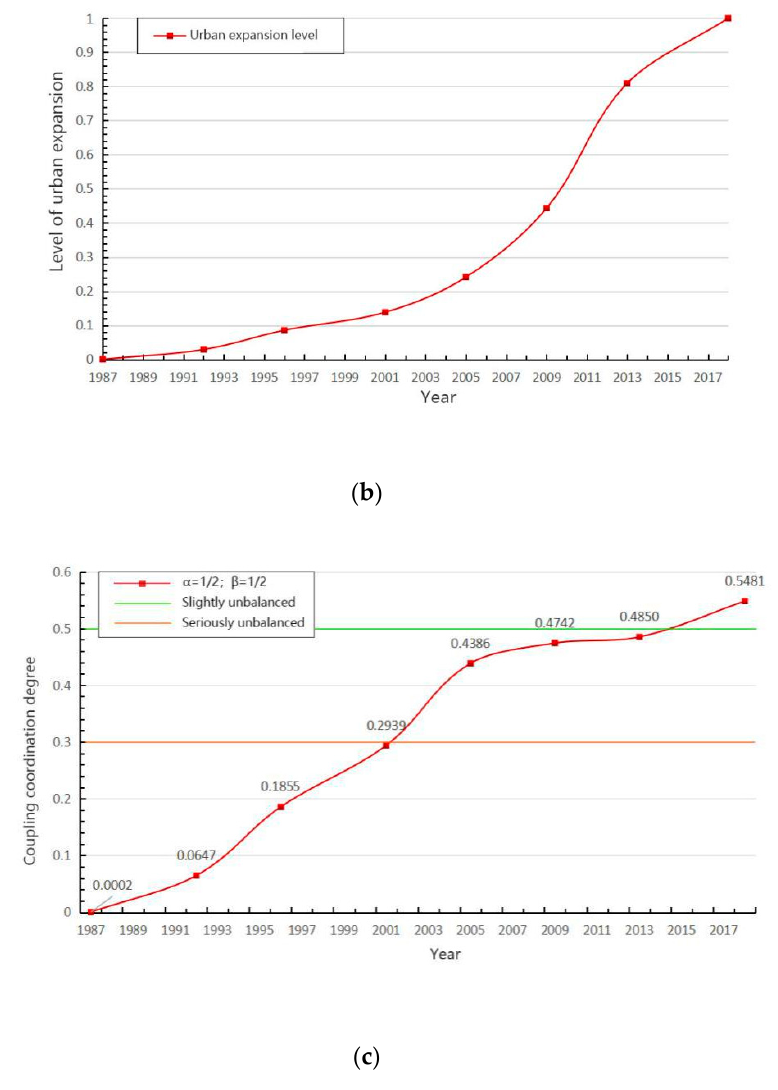
Figure 8. ( a ) Trends in the comprehensive levels of the lake change system; ( b ) the trend in the level of the urban expansion system; ( c ) the coupling degree of urban built-up area and lake evolution in Wuhan urban development area